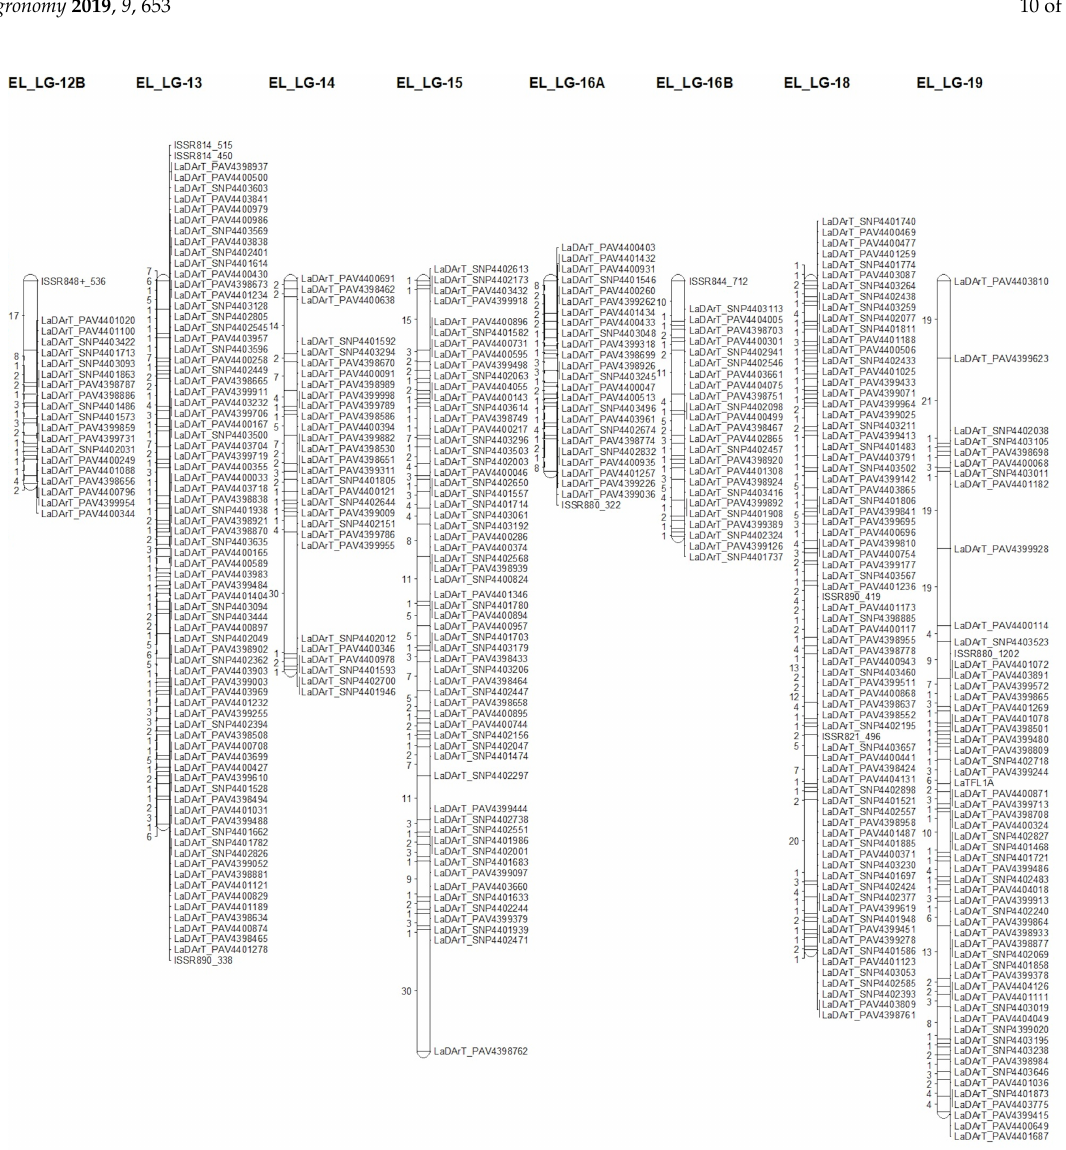
Figure 2. Genetic linkage maps for EL population—Linkage Groups (LG).